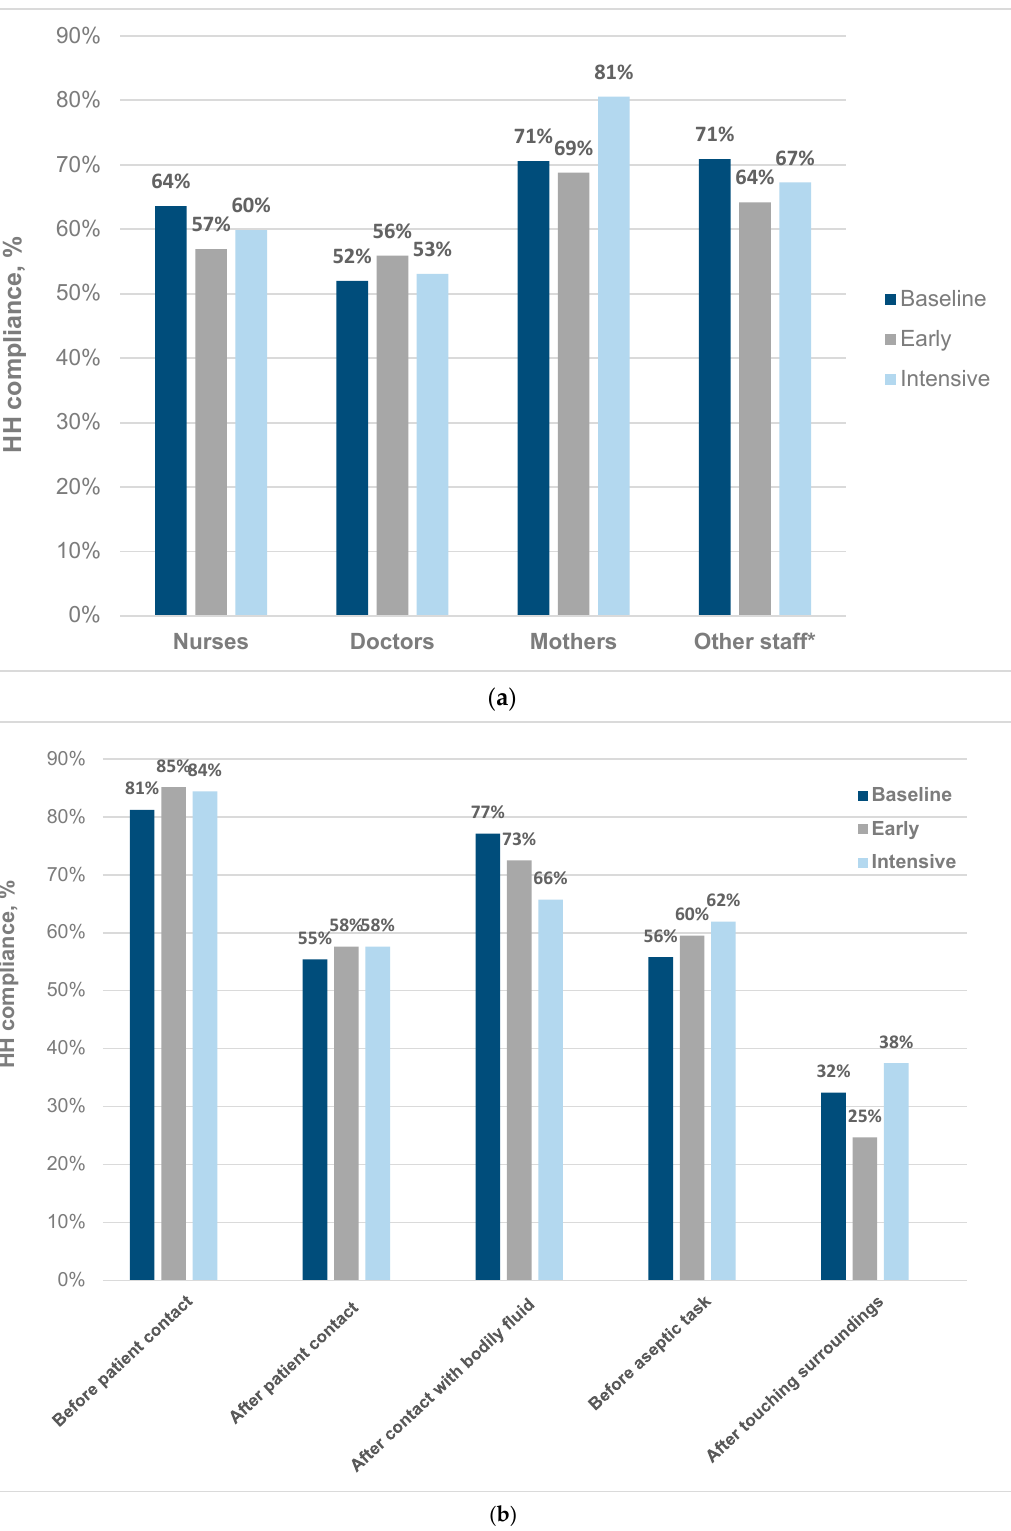
Figure 1. ( a ) Hand hygiene compliance rates by neonatal unit role and study phase. ( b ) Hand hygiene compliance by WHO five moments for HH type and study phase. *Other staff = cleaners, porters, radiology and allied health staff (physiotherapists, dieticians, porters, ward clerks, occupa- tional and speech therapists). HH compliance = HH performed/HH moments observed × 100 (% compliance). Table 1. Observed hand hygiene (HH) compliance rates by neonatal ward type and study phase.